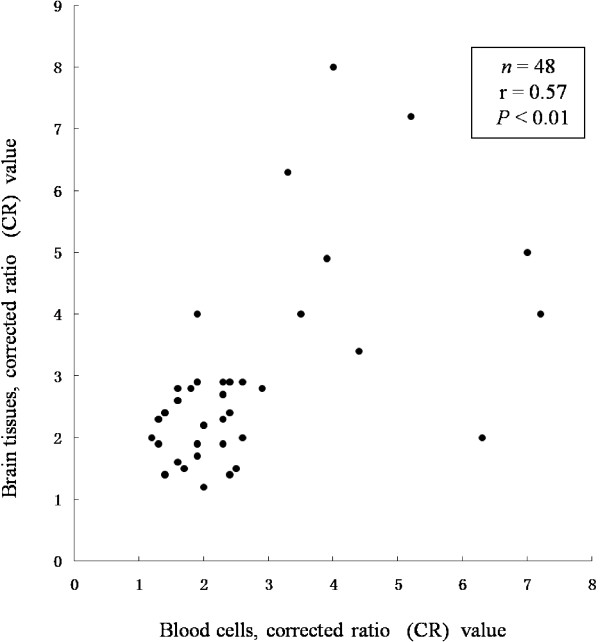
Scatterplot of corrected ratio (CR) values of SXCI between blood cells and normal brain tissues of the same individual.